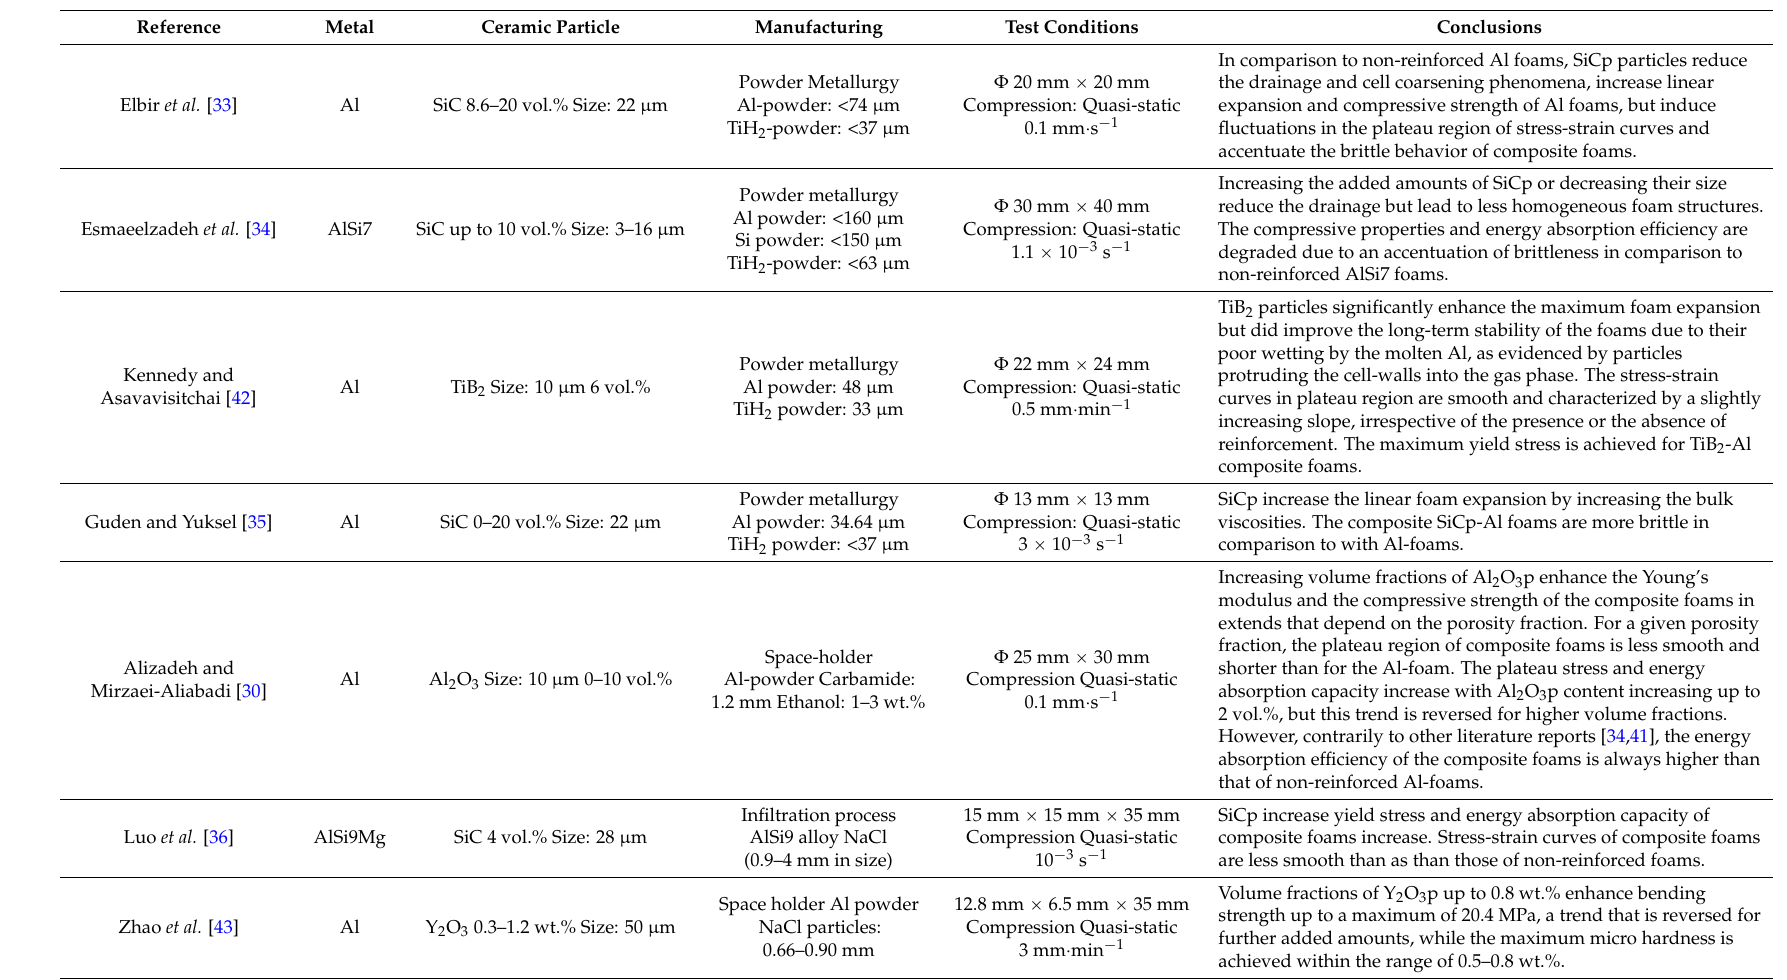
Table 1. Literature survey on ceramic particles reinforced foams prepared by powder